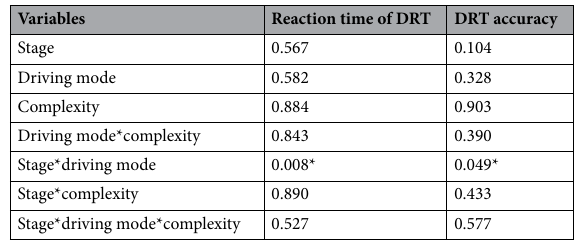
Table 1. A summary table of the ANOVA significance of DRT (*p <